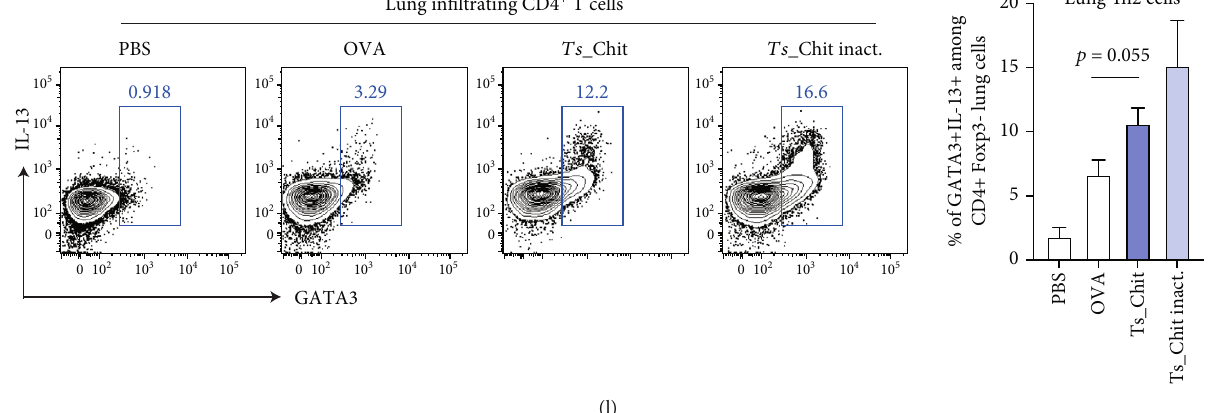
Figure 4: Ts- Chit treatment mediates attenuation of airway hyperreactivity. Bronchoalveolar lavage (BAL) was performed two days after OVA challenge, and the BAL fl uid was examined for (a) total number of in fi ltrating cells (Neubauer chamber), (b) BAL eosinophils, (c) BAL neutrophils, and (d) monocytes/macrophages using cytospin preparations and Di ff -Quik staining. (e) Representative plots of BAL- in fi ltrating cells using fl ow cytometry and focusing on eosinophil frequencies (identi fi ed as CD45 + CD11b + GR1 low CD11c - SiglecF + ). Summary of fl ow cytometric analysis of (f) BAL eosinophils and (g) alveolar macrophages (CD45 + CD11b low CD11c + ). (h) Basal expiration time during PBS inhalation measured using whole-body double-chamber plethysmography 24h after OVA challenge. (i) Concentration response curve of methacholine sensitivity. Speci fi c airway resistance ( S raw ) was assessed in response to increasing doses of methacholine. (j) S raw values recorded when nebulizing 50mg/ml of methacholine. (k) BAL cytokines detected two days after challenge using bead-based multiplexing. (l) Exemplary contour plots showing IL-13/GATA3 coexpression among lung-in fi ltrating CD4 + T cells of allergic mice. Bar graph summarizes GATA3 frequency among CD4 + Foxp3 - T cells of lung lymphocytes of treatment groups ( n = 4 – 5 mice per group). (a – k) Data are presented as mean ± SEM of n = 10 – 12 animals from n = 3 separate experiments. Statistical signi fi cance was assessed using a two-tailed Mann-Whitney test, and results are indicated by ∗ p ≤ 0 : 05 , ∗∗ p ≤ 0 : 01 , and ∗∗∗ p ≤ 0 : 001